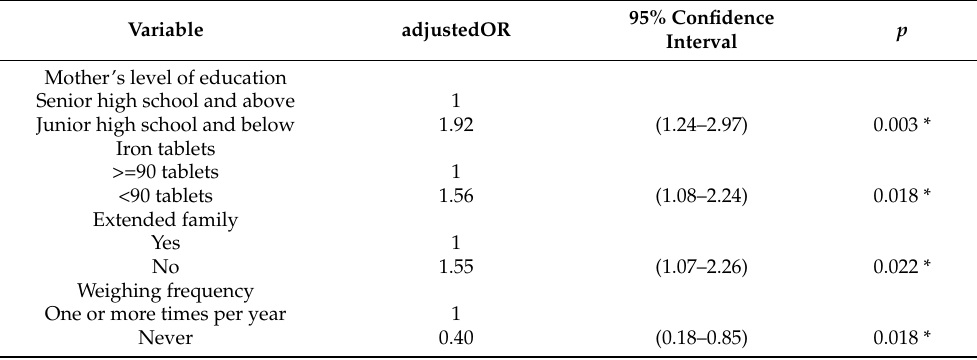
Table 3. Multivariate logistic regression analysis for association of stunting status with sociodemo- graphic and healthcare factors among children aged 6–59 months in Bali Province,